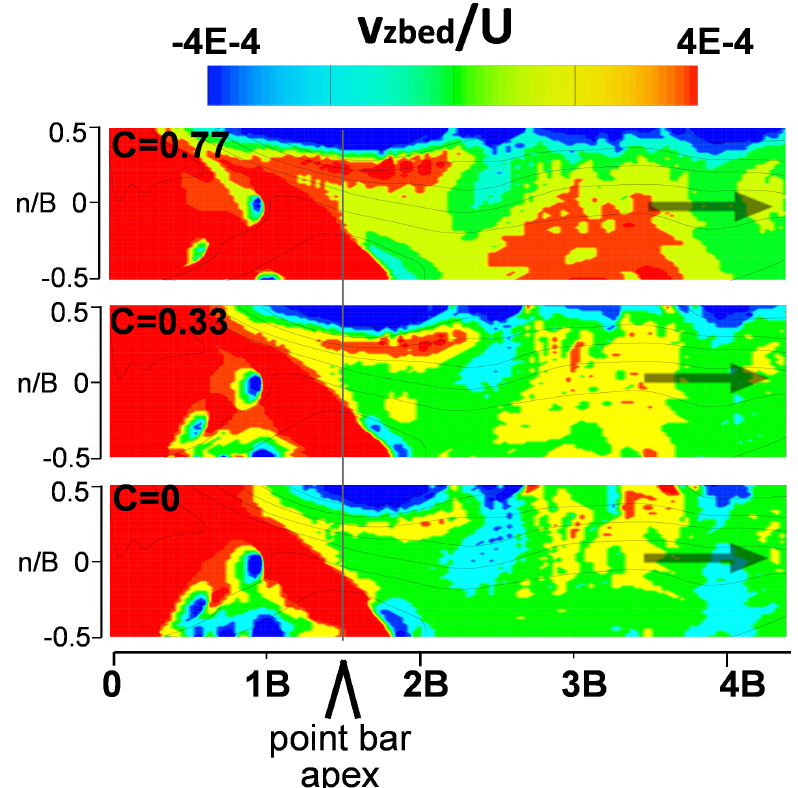
Figure 10. Normalized vertical hyporheic flux v zbed / U at 2 mm below sediment surface for channel curvature C = 0.77, 0.33, and 0 conditions. Positive indicates upwelling of groundwater into the river